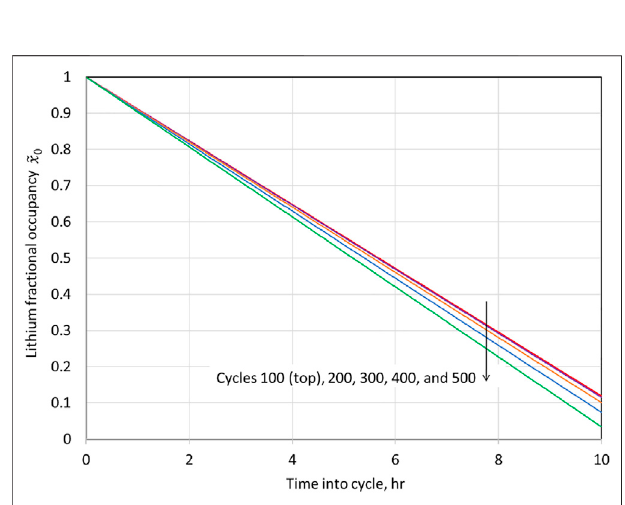
FIGURE 9 | Calculated leading-order term ~ x 0 ( t ) , see Eq. 68 , for the fractional occupancy of Li in the Li layer of the NMC622 during various